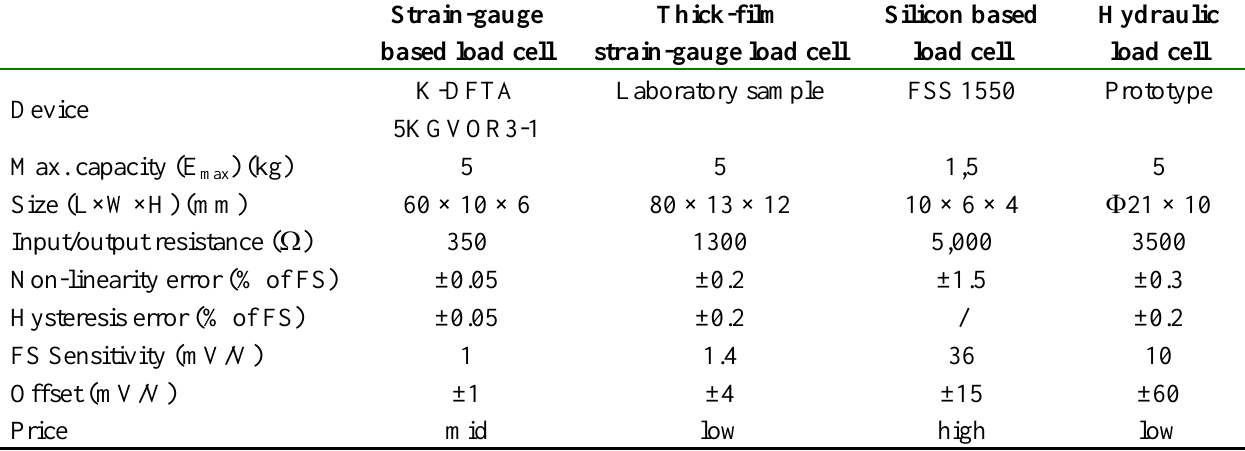
Table 4. comparison with other load cell candidates for the target